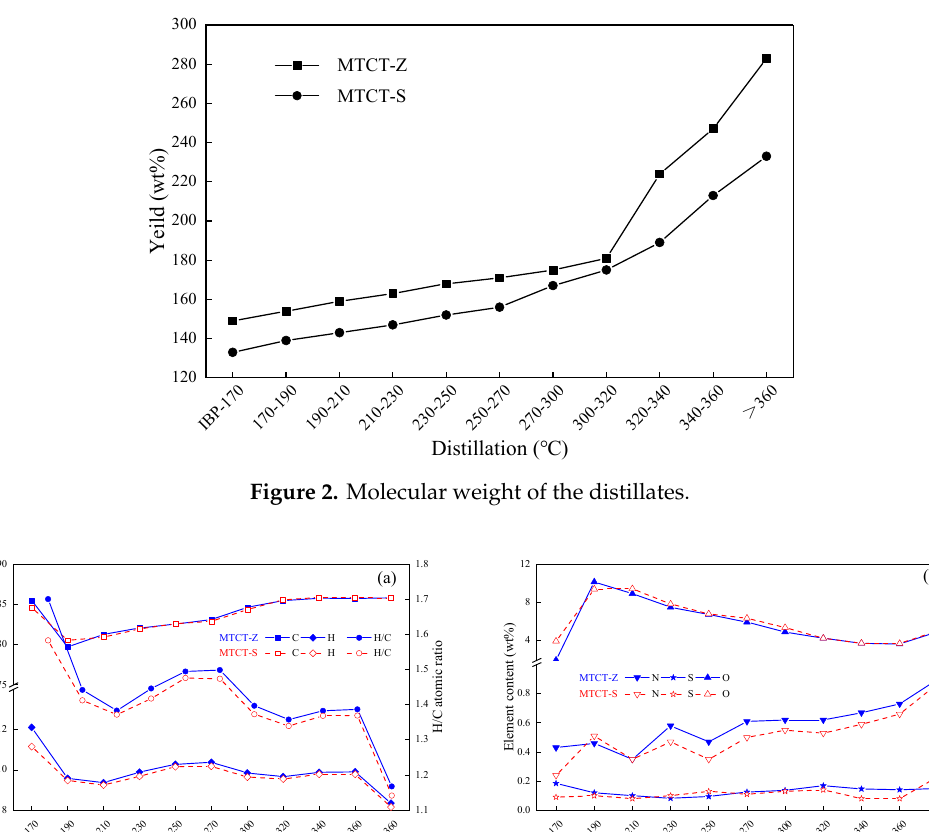
Figure 2. Molecular weight of the distillates.